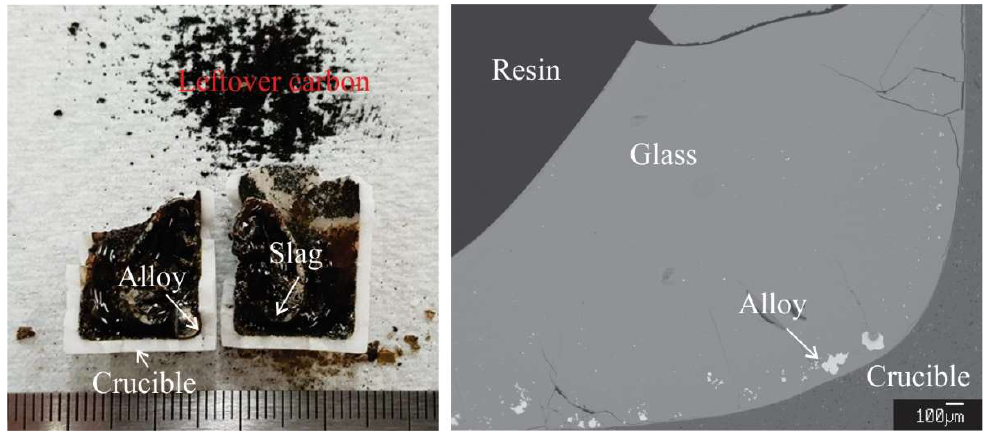
Figure 6. Pictures and microstructures of quenched samples after smelting at 1350 °C. ( a ) Sample ND8 (2 wt% graphite addition); ( b ) sample ND9 (4 wt% graphite addition); ( c ) sample ND10 (6 wt% graphite addition).